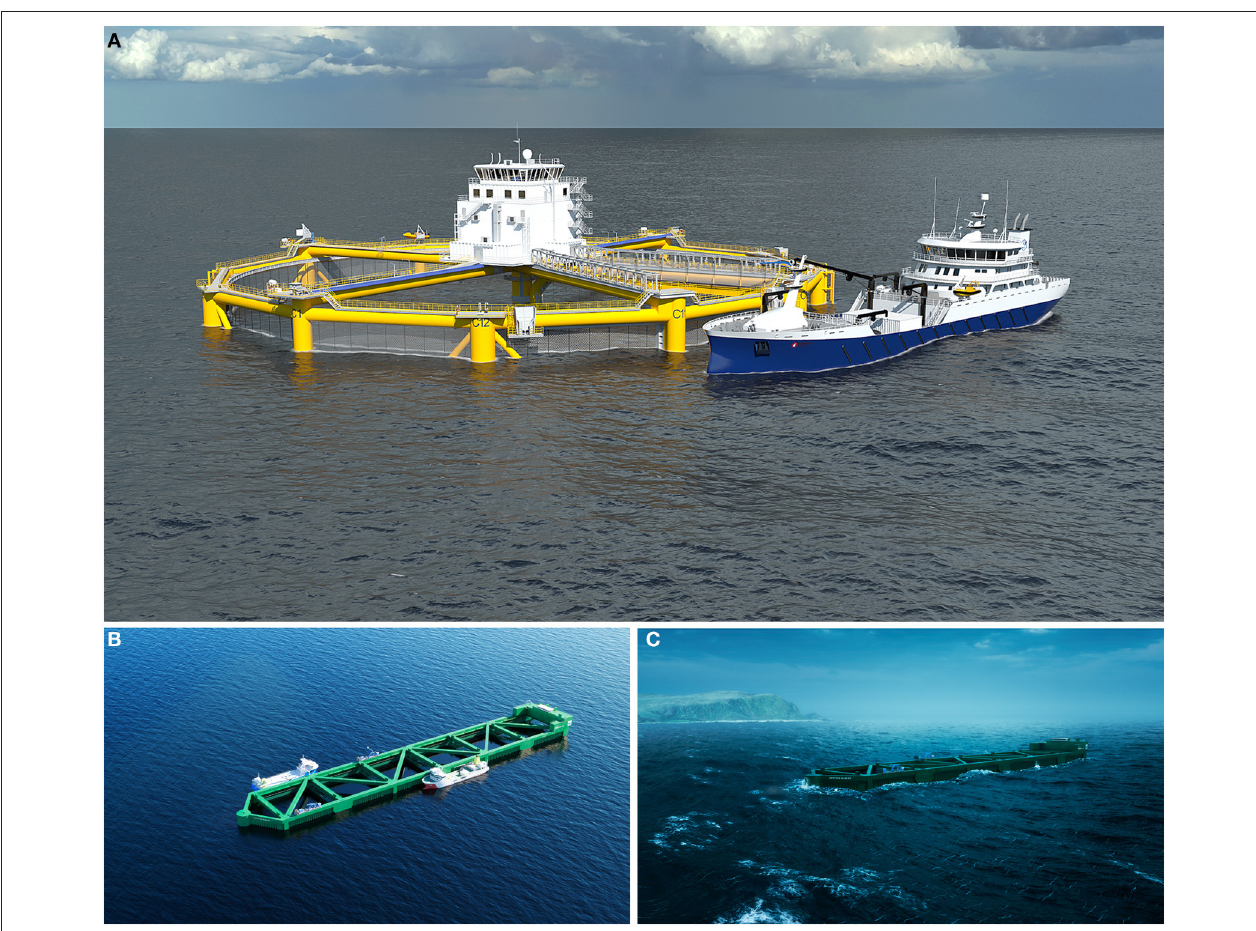
FIGURE 5 | (A) Large offshore fish farm device with a diameter of 110m, a height of 67m and a volume of 245,000 m 3 (upper image). This fish farm was just recently built in an Asian shipyard, transferred to Norway and could produce 6,000t of salmon. (B,C) Havfarm 1 : Large aquaculture production unit integrated into a vessel-like floating platform in calm (lower left) and rough (C) conditions at sea (lower right). Havfarm 1 includes next to the large cages a mini-harbour for service vessels, maintenance trolleys along the outer rails providing access to the entire facility, rotatable thrusters to reduce stress on the mooring during storm conditions while